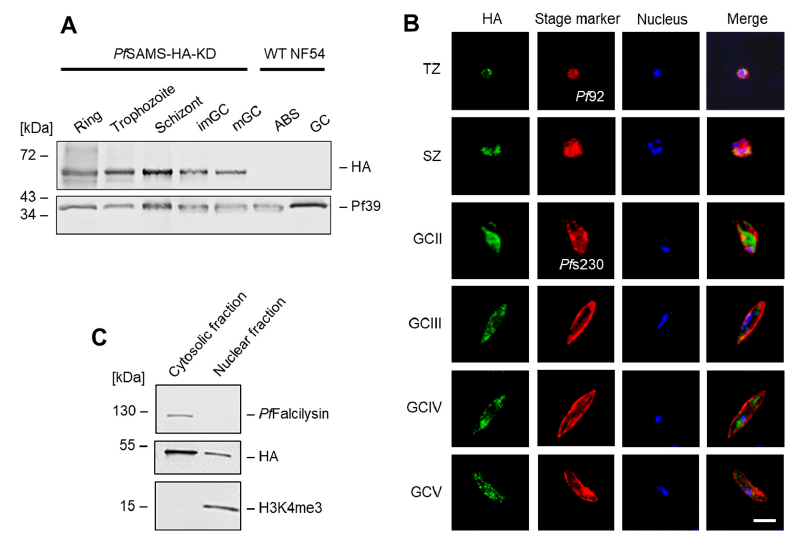
Figure 1. Expression and localization of Pf SAMS-HA in the P. falciparum blood stages. ( A ) Expres- sion of Pf SAMS-HA in blood-stage parasites. Lysates of asexual blood stages (ABS) of the ring, trophozoite, and schizont stage and of immature (imGC) and mature (mGC) gametocytes of the Pf SAMS-HA-KD parasite line were immunoblotted with rat anti-HA antibody to detect Pf SAMS- HA (~50 kDa); immunoblotting with antisera directed against Pf 39 (39 kDa) was used as loading control. ( B ) Localization of Pf SAMS-HA in the asexual blood stages and gametocytes. Immunoflu- orescence assays were employed, using rat anti-HA antibody, to detect Pf SAMS-HA in trophozoites (TZ), schizonts (SZ), and gametocytes (GC) of stages II–V (green), of the Pf SAMS-HA-KD parasite line. Counterlabeling of the asexual blood stages was done using mouse anti- Pf 92 antisera and of gametocytes with rabbit anti- Pf s230 antisera (red). The nuclei were labeled with Hoechst 33342 nu- clear stain (blue). Bar; 5 µm. ( C ) Subcellular fractionation of Pf SAMS-HA parasites. Nuclear and cytosolic fractions were obtained from schizonts of the Pf SAMS-HA-KD parasite line and the frac- tions were immunoblotted with rat anti-HA antibody. Purity of the nuclear and cytosolic fractions was confirmed by immunoblotting with mouse antiserum directed against the cytosolic protease Pf Falcilysin (138 kDa) and rabbit antibody directed against the nuclear histone H3 mark H3K4me3 (15 kDa), respectively. The results ( A – C ) are each representative of three independent experiments. 3.2. PfSAMS Deficiency Impairs Intraerythrocytic Growth and Gametocyte Development To induce the conditional knockdown of Pf SAMS-HA synthesis, asexual blood-stage parasites were treated with 5 mM GlcN for 72 h. Upon GlcN addition, Pf SAMS-HA levels were significantly reduced to 50.1 ± 7.27% compared to the untreated control, as shown by quantitative Western blotting (Figure 2A,B). The Pf SAMS-HA-KD line was then investigated for intraerythrocytic development of the asexual blood stages. Growth assays revealed that the parasitemia of synchronized asexual blood stages treated with 5 mM GlcN was significantly reduced after 72 h when compared to untreated Pf SAMS-HA-KD parasites and GlcN-treated or untreated WT NF54 parasites (Figure 2C). No significant difference in the parasitemia was observed when GlcN-treated and untreated WT NF54 were compared at 72 h. In addition, quanti- fication of ring, trophozoite, and schizont stages at different time points did not reveal a major effect of GlcN-treatment on parasite stage development of Pf SAMS-HA-KD and WT NF54 parasites (Figure S3), suggesting that the lack of Pf SAMS affects parasite viability, but does not delay the blood-stage cycle.